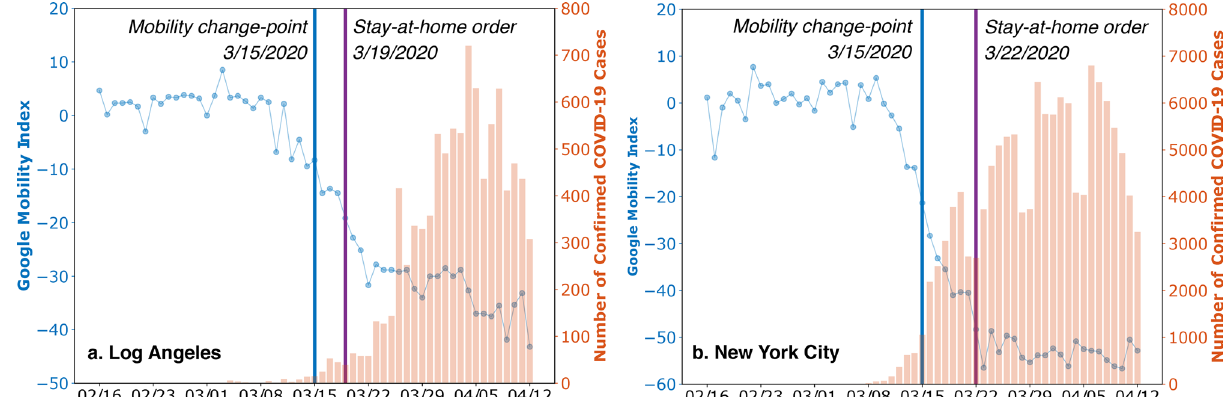
Figure 1. Detected mobility change-points, Stay-at-Home order dates, daily new COVID-19 cases, and Google Mobility Index of LA and NYC are shown.